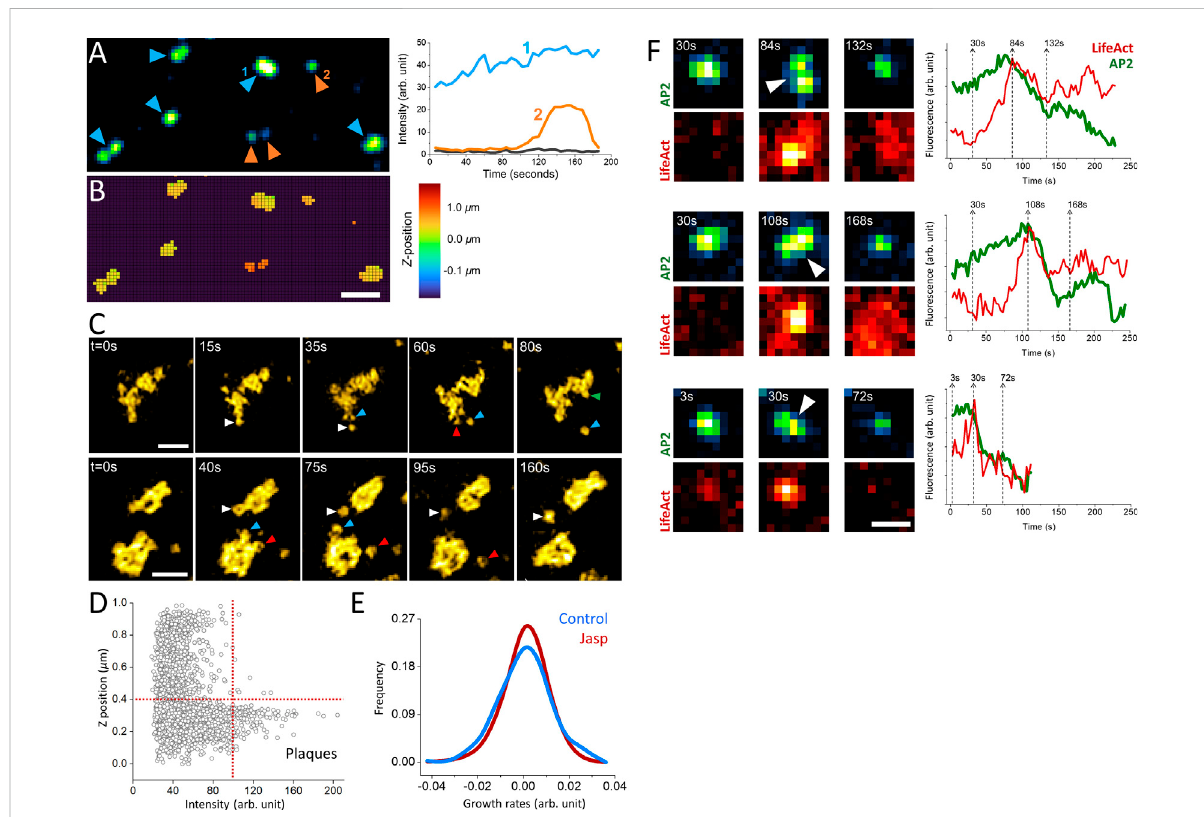
FIGURE 2 Roleofactininclathrincoatdynamicsunderhighmechanicalload. (A) Clathrin-coatedpitsandplaquesareimagedontheventralsurfaceoflive SUM-159 cells using spinning-disk confocal microscopy. The blue and orange arrowheads mark plaques and pits, respectively. Representative fl uorescenceintensitiesofaclathrinplaque(1) andpit(2)areshownontheleftpanel,where theblacklineshowsthebackground intensity.Although itsintensityhaschangedovertime,theclathrinplaquewasobservablethroughouttheentireacquisition.Whereastheclathrinpitintheexample hadalifetimeof~100 s,itappearedaroundthe90thsecondandwasinternalizedattheendoftheacquisition. (B) Theaveragez-positionsofthepits and plaques in (A) are determined for each pixel as described earlier (Kural et al., 2012). Plaques are localized to membrane-substrate adhesion sites and, therefore, are found in the same axial position. Whereas the clathrin pits are often observed at higher z positions (Ferguson et al., 2016). Scale bar, 1 µm. (C) Examples show endocytic pits (marked by arrowheads with distinct colors) budding off from large clathrin plaques. Scale bars, 1 µm. (D) Scatterplotshows therelativez-position versusthemaximum intensity ofclathrin-coated structures detectedat theventral surfaceofSUM-159 cells genome edited to express AP2-EGFP (N cells = 2; N traces = 3736). The dashed lines denote the thresholds used to select plaques, which are brighter than pits and positioned closer to the substrate (Ferguson et al., 2016). (E) After plaques are identi fi ed as described in (D) , their growth rate distributionsareplottedpriorto(Control,N TraceFragments =365)and10 minaftertreatmentwith1 µMJasplakinolide(Jasp,N TraceFragments =1944).The narrower growth distribution upon Jasp treatment is a result of slower plaque dynamics upon inhibition of actin machinery (Ferguson et al.,